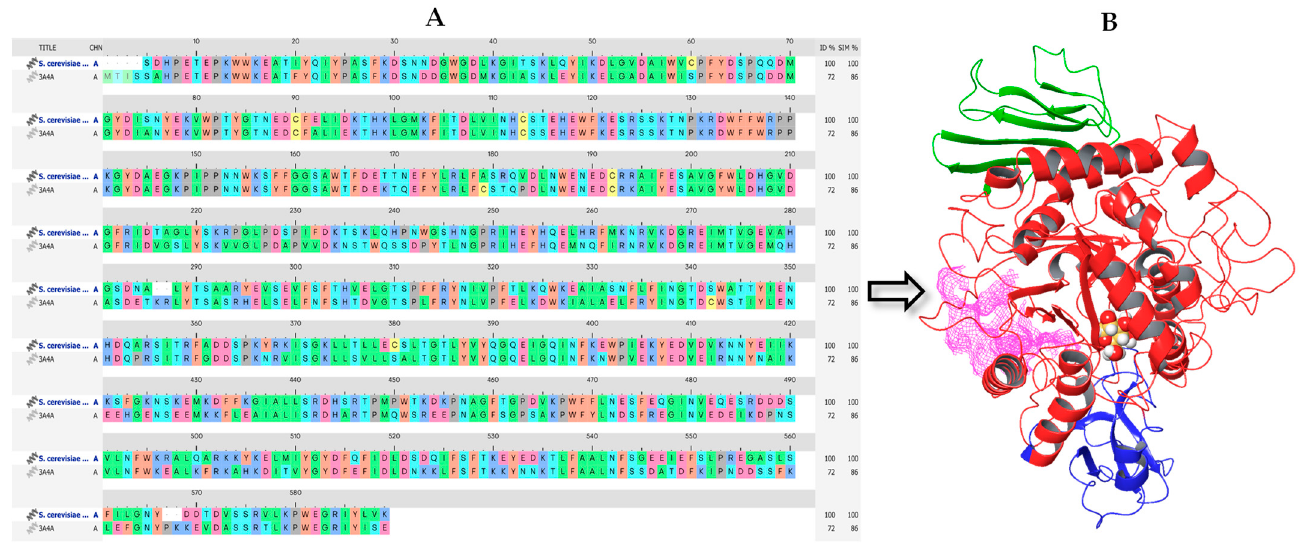
Figure 5. ( A ) Aligned protein sequences of S. cerevisiae yeast α -glucosidase and yeast isomaltase (PDB: 3A4A) showing the sequences similarity and identity. ( B ) α -Glucosidase homology model built from the 3A4A structure. The most probable allosteric site obtained from SiteMap calculations is depicted as a mesh surface while glucose bound at the active site is shown in CPK representation.